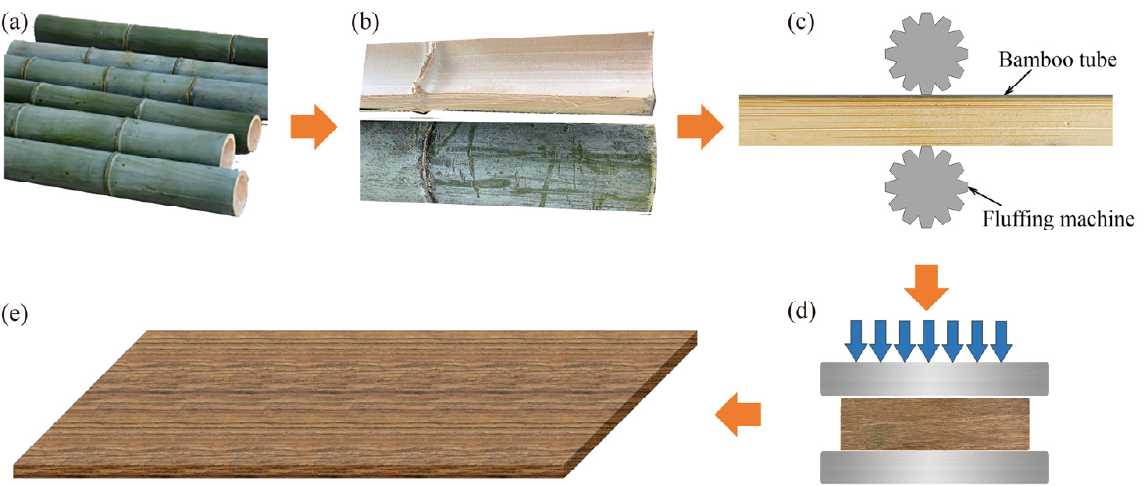
Figure 1. The manufacturing process of BS: ( a ) full-pole bamboo; ( b ) splitting; ( c ) fluffing; ( d ) hot pressing; ( e ) a bamboo scrimber panel.